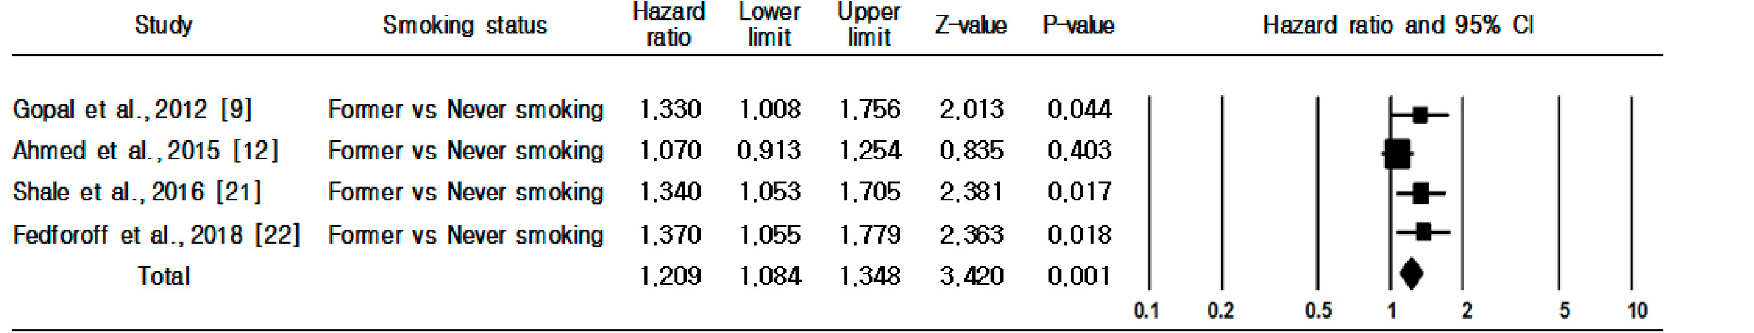
Figure 3. Heart failure incidence in former smokers versus never smokers.